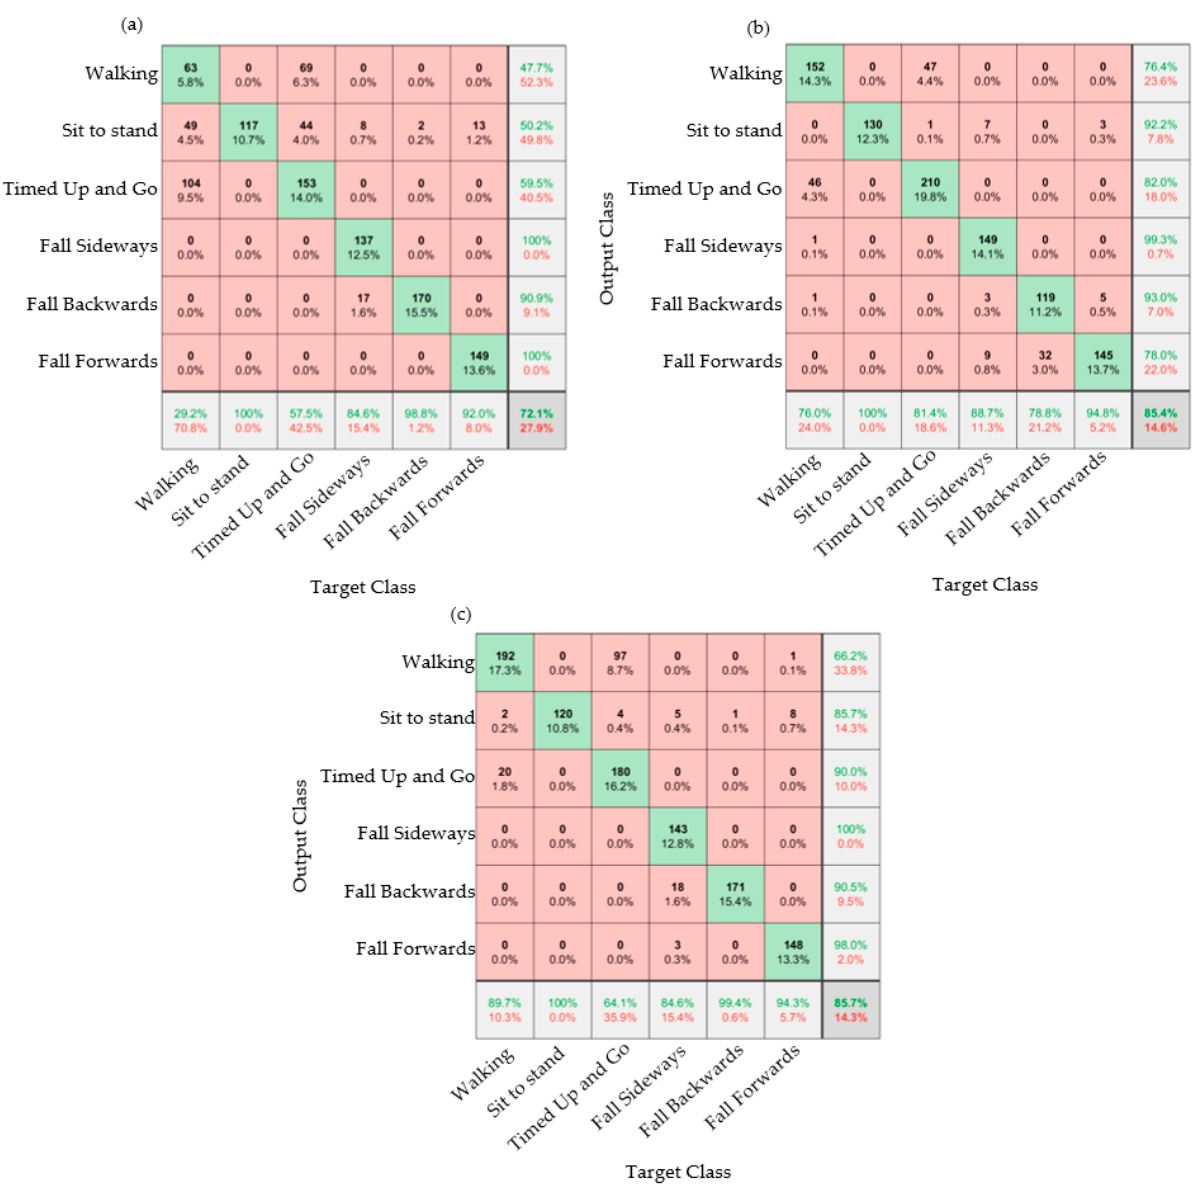
Figure 7. Confusion matrices for the data taken from the right foot. ( a ) Acceleration data. ( b ) Angular velocity data. ( c ) Both acceleration and angular velocity data.